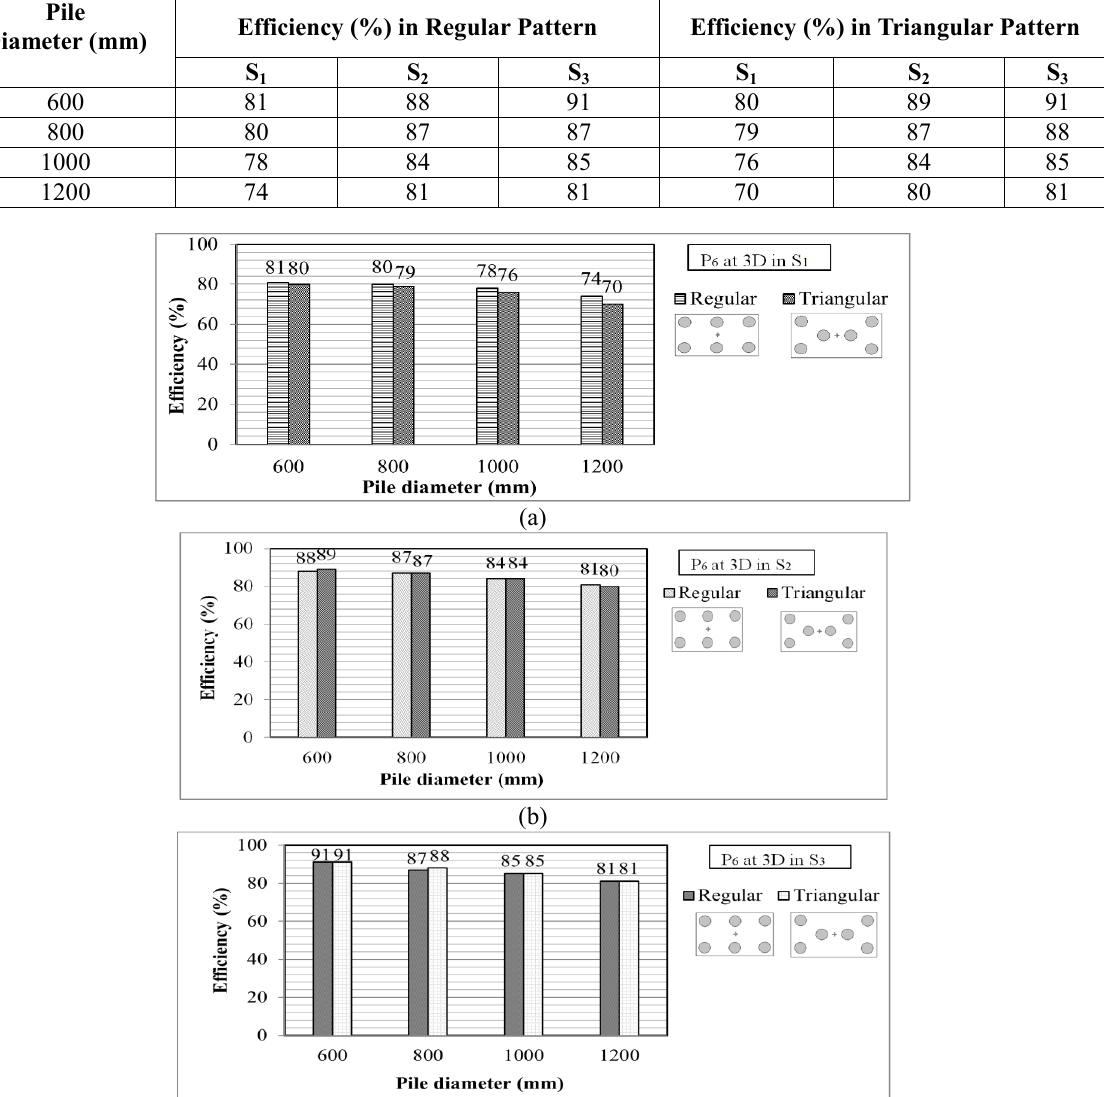
Fig. 8. Group efficiency of six piles in two orientations